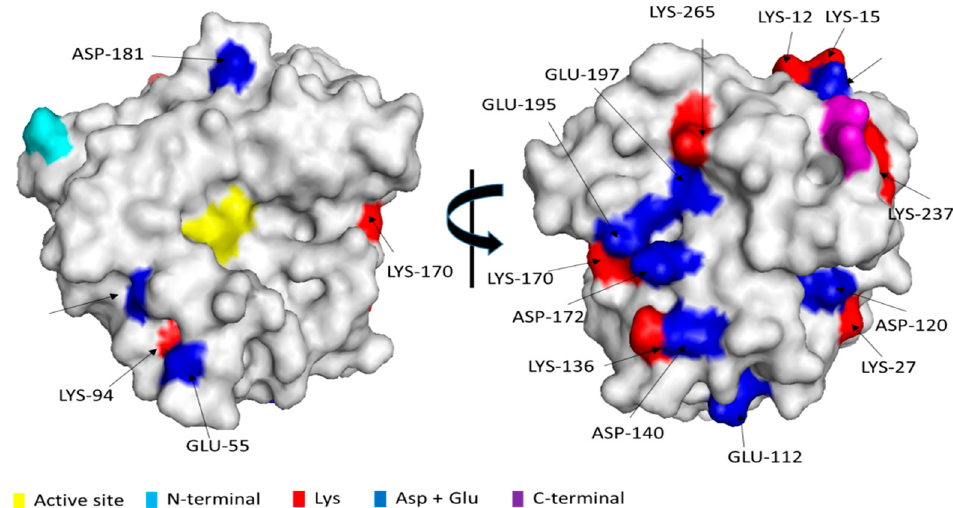
Figure 2. 3D surface structure models of Alcalase (PDB code 1SBC). The 3D structures were obtained from the Protein Data bank (PDB) and displayed using Pymol software version 0.99rc6.